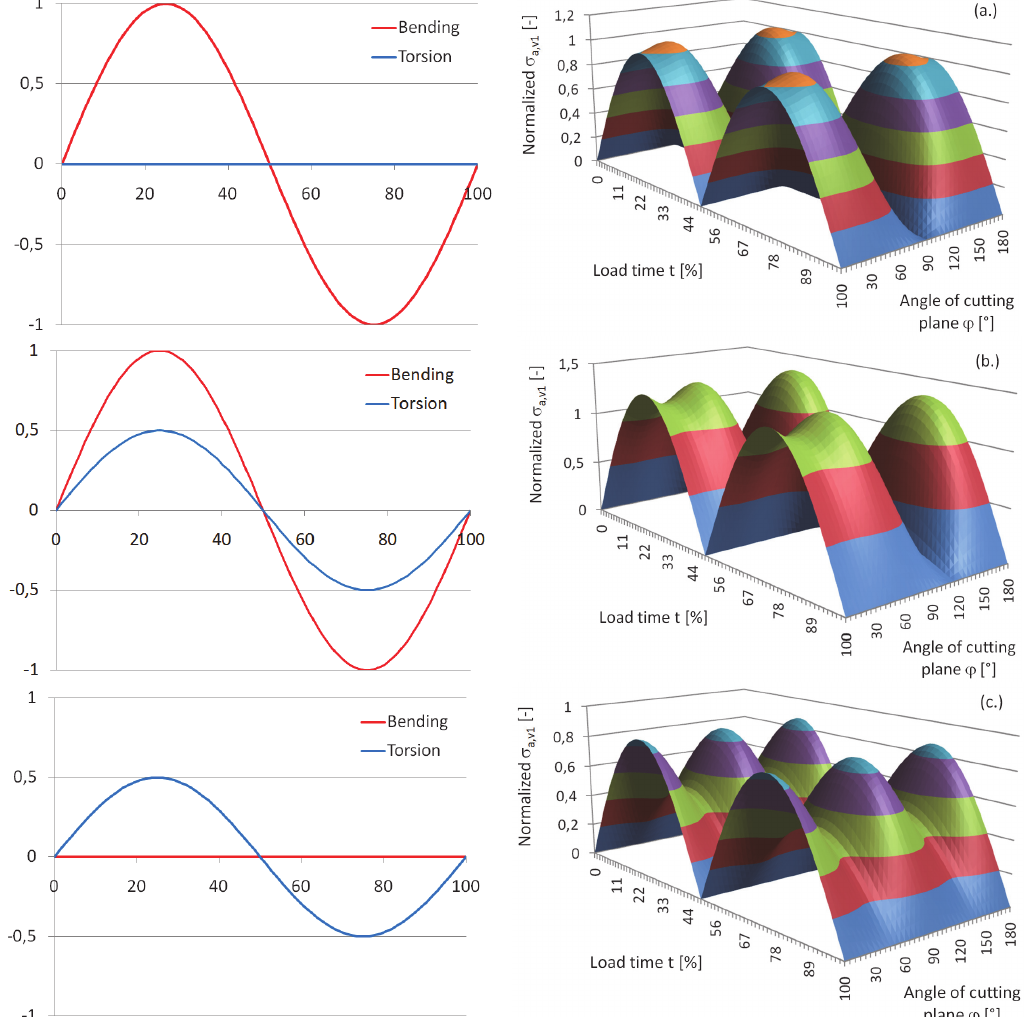
Figure 6: Normalized equivalent stress  v1 for (a.)  T /  B =0 (bending only), (b.)  T /  B =0.5 (bending and torsion) and (c.)  T /  B = ∞ (torsion